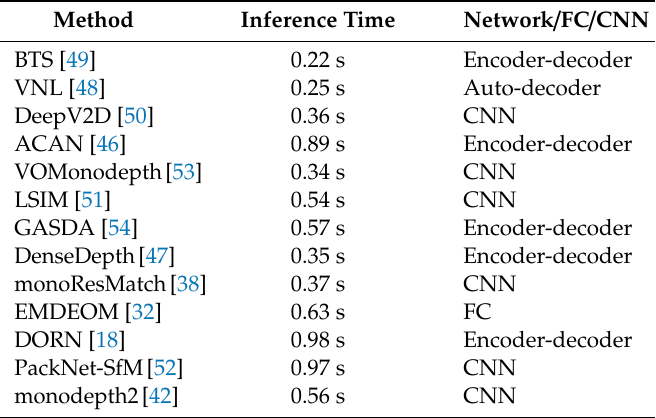
Table 6. Comparison of the models in terms of inference time (FC: fully convolutional; CNN: convolutional neural networks). Best method is emboldened and highlighted in green.